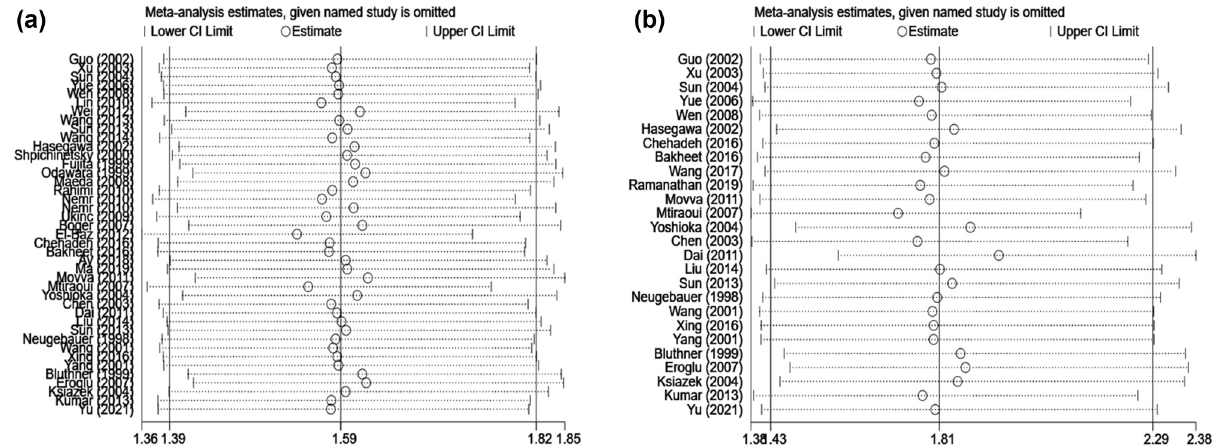
Figure 3: Sensitivity analysis of the relationship between MTHFR C677T and DN risks in allelic model. ( a ) Comparison with DM controls and ( b ) comparison with healthy controls.